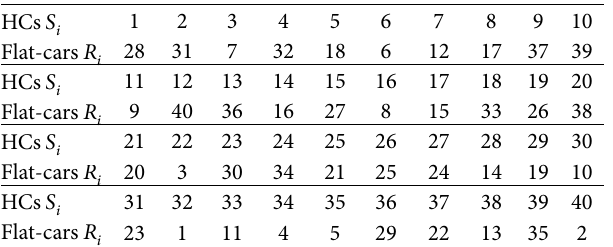
Table 1: The match table of outbound containers and railway flat cars.